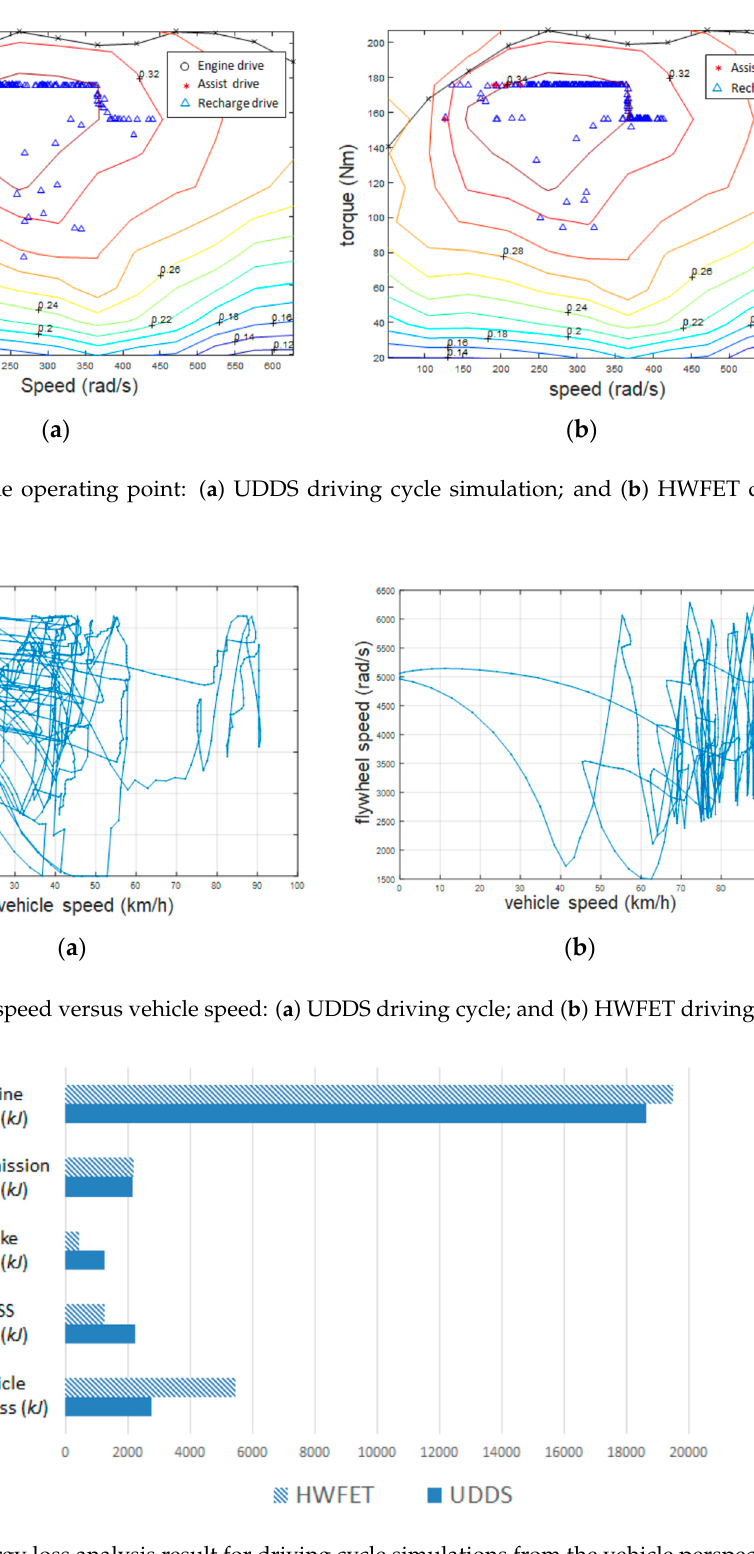
Figure 22. Energy loss analysis result for driving cycle simulations from the vehicle perspective.